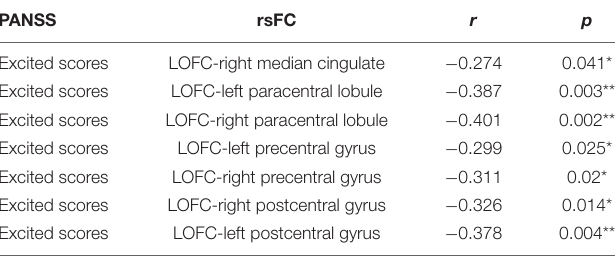
TABLE 4 | Correlations between the rsFC values and PANSS excited scores in patients with FES. PANSS